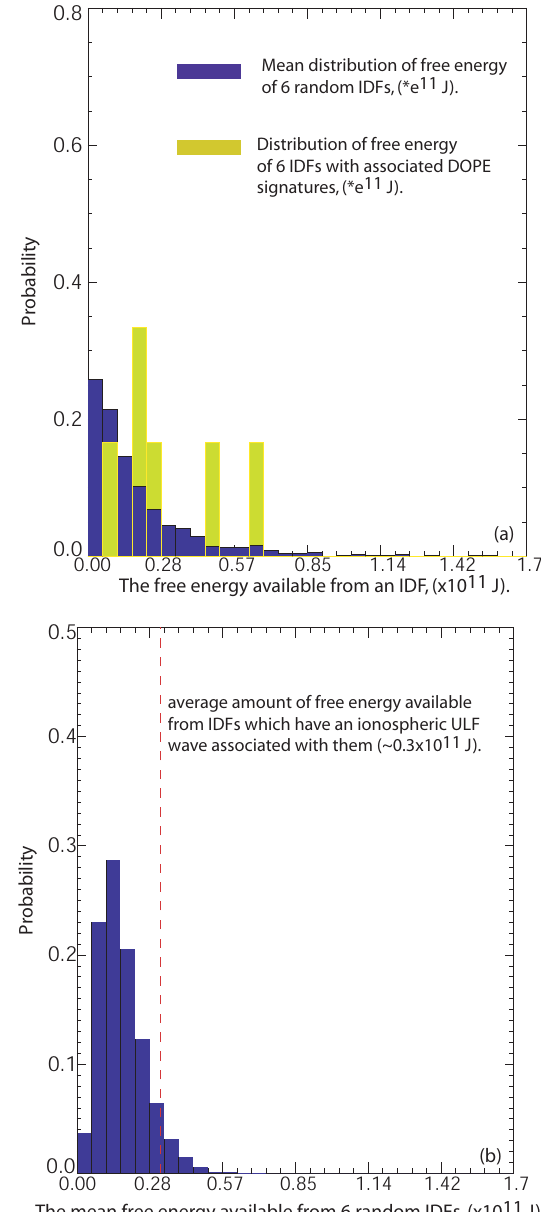
Fig. 6. The Monte Carlo analysis results for the two tests described in the text. Panel ( a ) shows the probability distribution for the amount of free energy of 6 random IDFs. The x-axis indicates the free energy available from an IDF. The blue (Monte Carlo) distri- bution is the mean free energy distribution of 6 randomly extracted IDFs. The yellow distribution is the free energy distribution for the conjugate IDFs. Panel ( b ) shows the distribution of the average free energy available from a sample of 6 random IDFs extracted from the database described in this paper. The average free energy for the 6 IDFs for which a conjugate ionospheric ULF wave was detected by DOPE is marked with a vertical red dashed line. A valve of 93.6% of the distribution lies below this red line, indicating a statistical cause and effect relationship between the driving particle popula- tions and the ULF